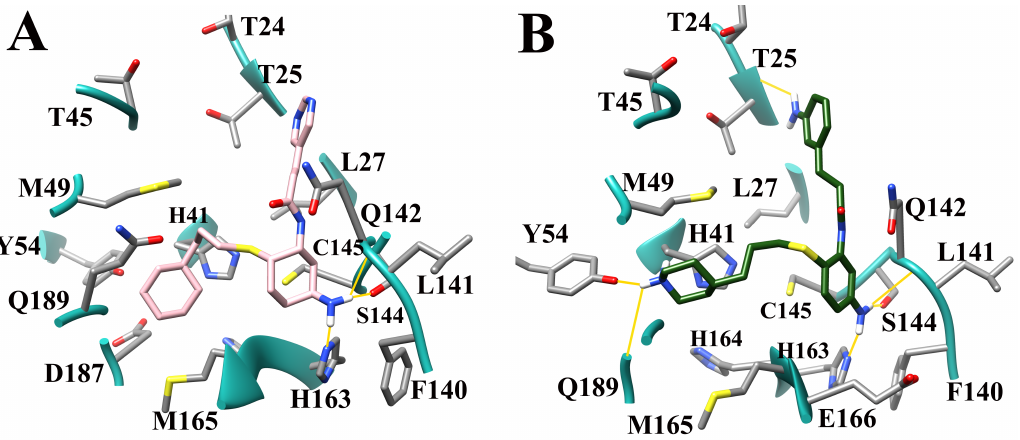
Figure 18. Mode of binding of the optimized cinanserin compounds ( A ) CM06 (pink); and ( B ) CM07